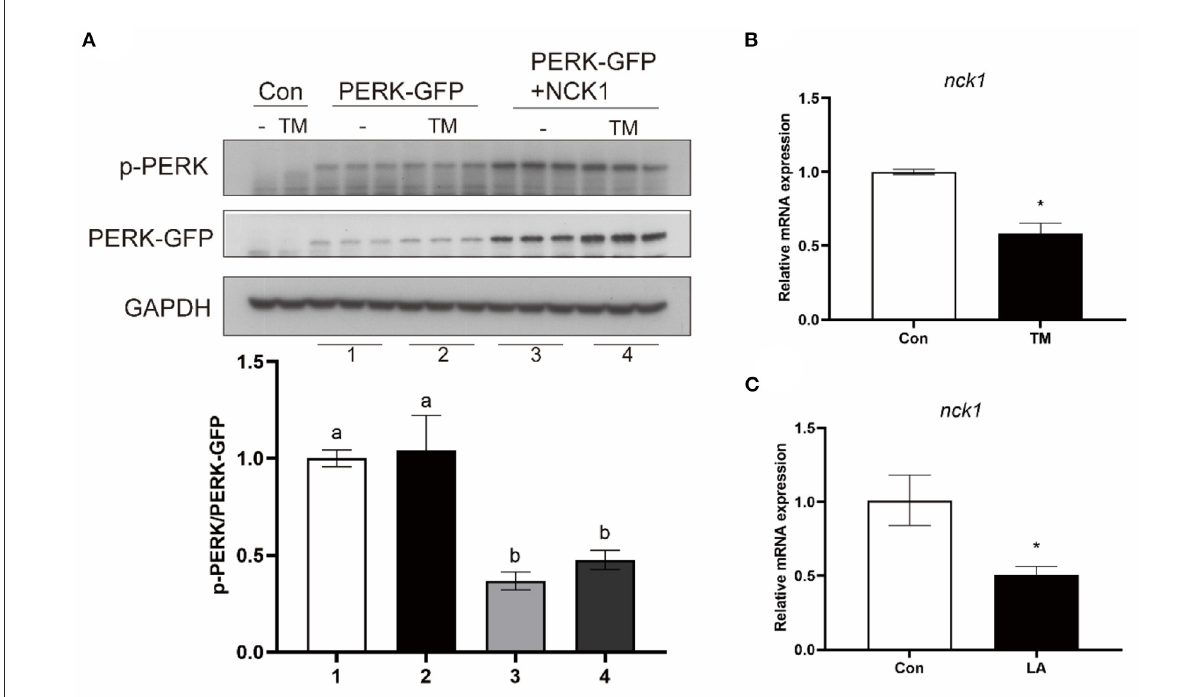
FIGURE7 Effects of NCK1 on PERK in large yellow croakers. (A) Phosphorylated PERK immunoblot in HEK 293T cells after NCK1 overexpression. (B,C) NCK1 expression in macrophages after treatment with TM and LA. The significance was analyzed by one-factor ANOVA and Duncan’s Multiple Range Test (means ± SEMs; n = 3). Means without the same label were considered different, P < 0.05. *Different between two groups (Student’s t